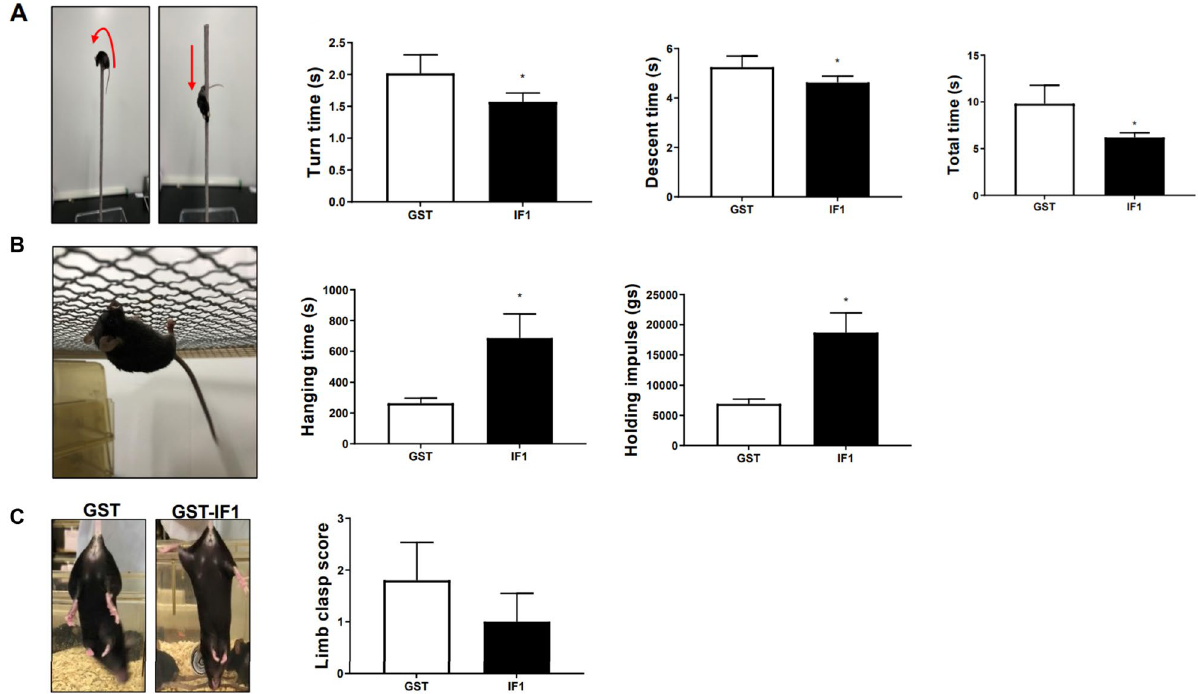
Figure 4. Administration of IF1 improves motor behavior of α-syn transgenic mice. Administration of IF1 in mice overexpressing α-synuclein was conducted to investigate the PD-like behavior abnormalities. ( A ) The pole test was conducted and each parameter, turn time, descent time, and total time, were compared within groups (GST, n = 5; IF1, n = 5). ( B ) Strength was assessed by hanging test. Hanging time and holding impulse from each group were evaluated. ( C ) Limb clasp performance was scored (left panel) and presented as a bar graph (right panel). Data are expressed as mean ± SEM, *p < 0.05. One-way ANOVA with a Tukey’s post-hoc